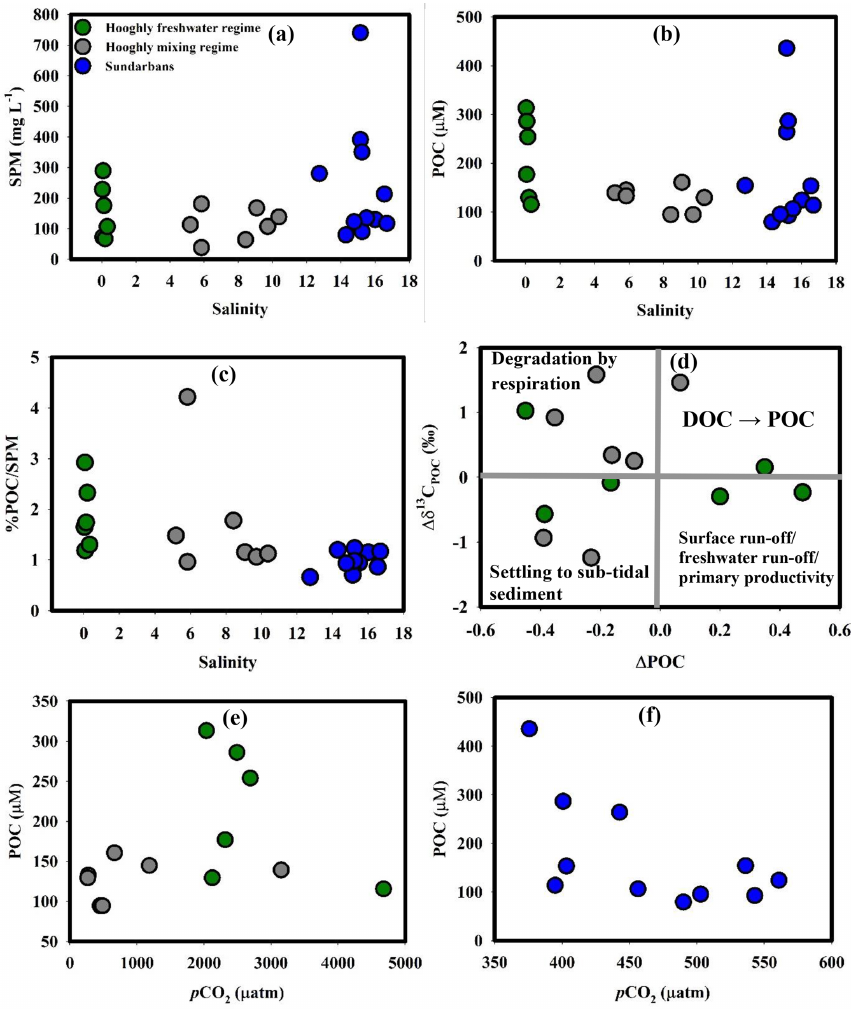
Figure 5. (a) SPM–salinity in the Hooghly–Sundarbans system, (b) POC–salinity in the Hooghly–Sundarbans system, (c) %POC / SPM– salinity in the Hooghly–Sundarbans system, (d) (cid:49) POC– (cid:49)δ 13 C POC in the Hooghly, (e) POC– p CO 2 in the Hooghly and (f) POC– p CO 2 in the